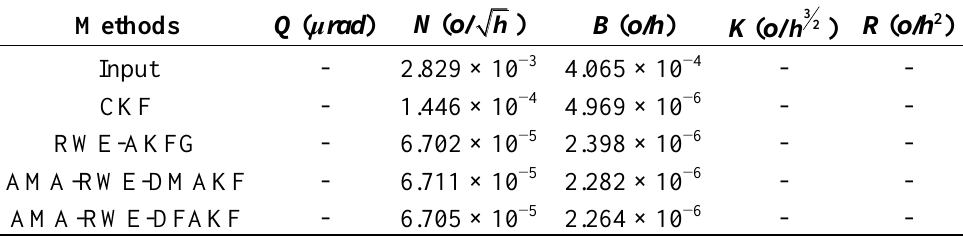
Figure 5. Allan variance analysis of FOG signal in static condition. Table 1. Allan variance analysis results of FOG signal in static